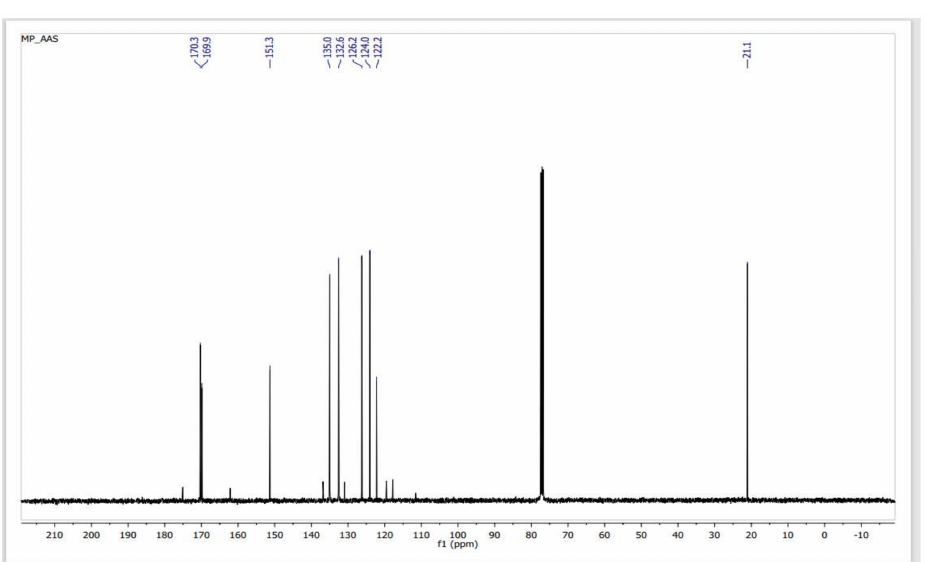
Figure 4. 13 C NMR spectra of a sample of MS obtained from the transesterification–esterification of ASA catalyzed by SiO 2 –SO 3